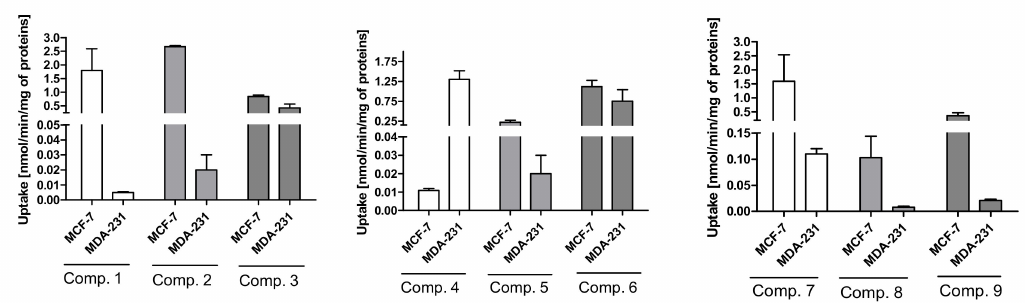
Figure 2. The uptake of sulfonamide derivatives of metformin into MCF-7 and MDA-MB-231 cells at an 800 µ mol / L concentration after 10 min incubation at 37 ◦ C. Metformin uptake was 0.107 ± 0.006 nmol / min / mg of proteins in MCF-7 cells and 0.117 ± 0.010 nmol / min / mg of proteins in MDA-MB-231 cells